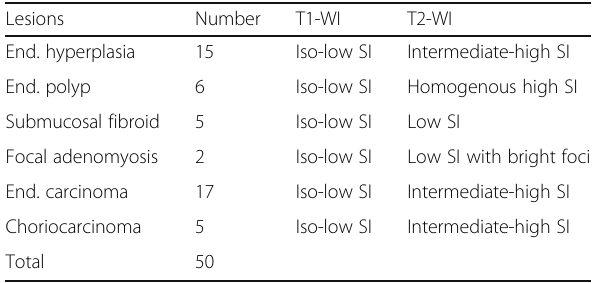
Table 2 Conventional MRI findings in all studied lesions ( n =